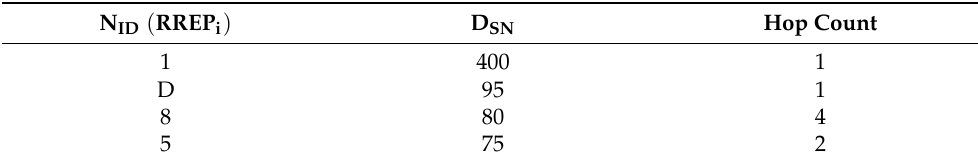
Table 3. RAT with the normal and malicious nodes’ RREPs.